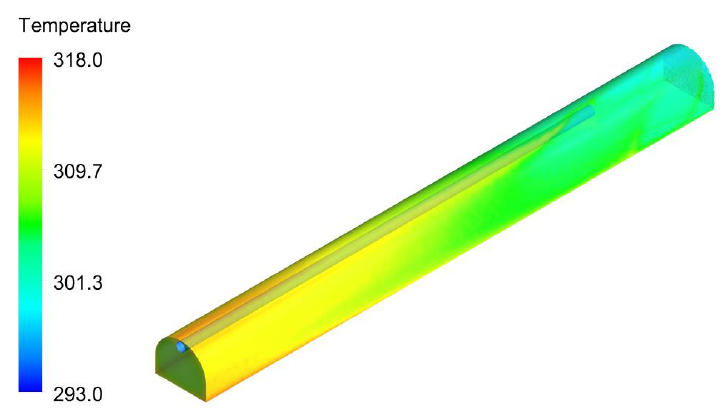
Figure 7. Model 2 side view (x = 0).